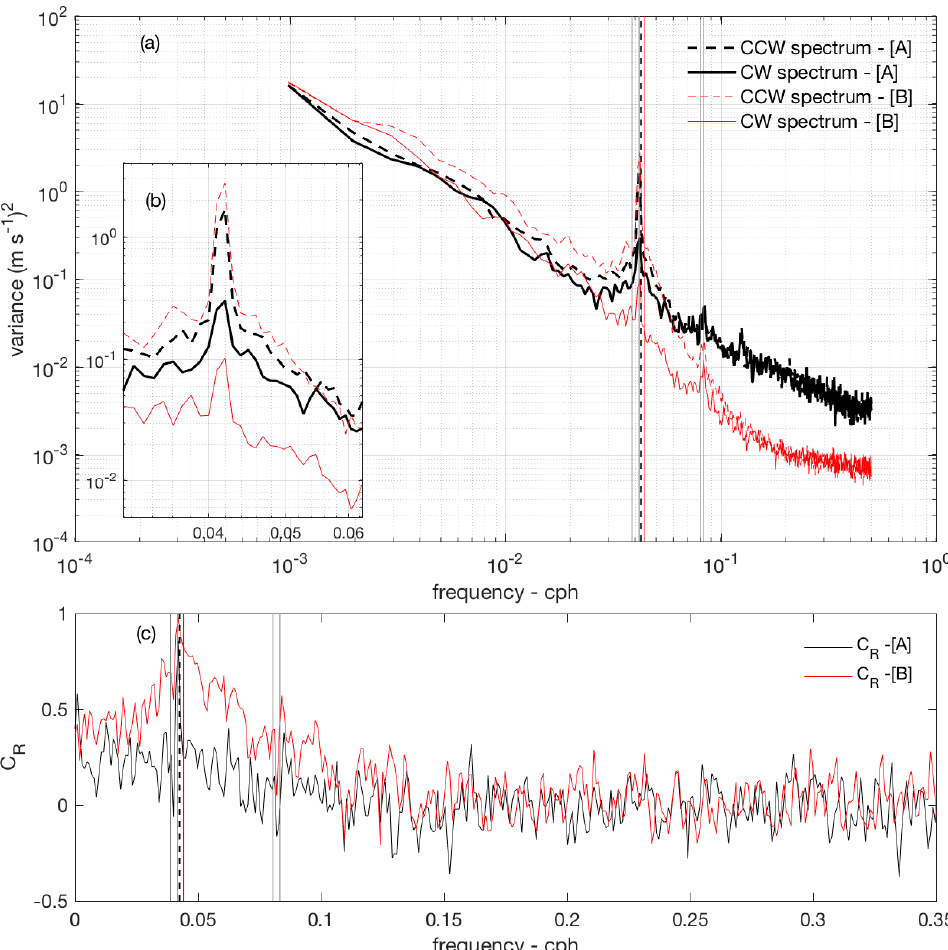
Figure 9. ( a ) Rotary power spectra of hourly surface currents at locations A (Seasonde) and B (WERA) (Figure 2) within the HFR domain showing the dominant spectral features in the region. Vertical lines identify the semidiurnal and diurnal frequency bands (thin grey lines), respectively; and, the inertial frequency at the two locations. ( b ) Same as ( a ), but for the diurnal frequency band. ( c ) Rotary coefficients (C R ) spectra derived from for ( a ). Units are m 2 s − 2 cph − 1 and cycles per hour (cph) for rotary spectra and frequency axis; C R is dimensionless.